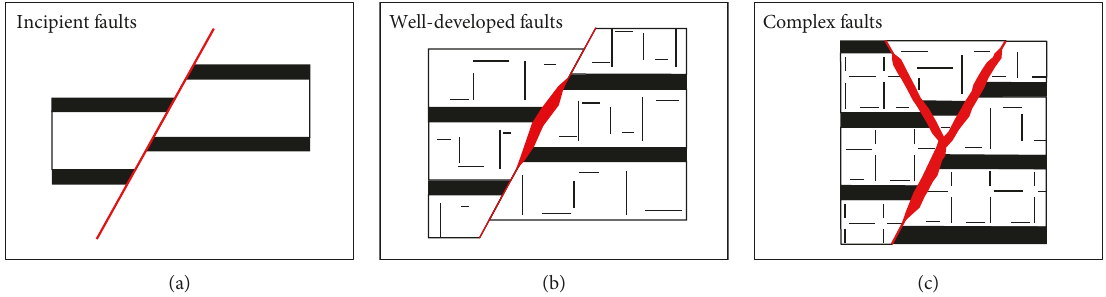
Figure 3: Faults were divided into groups based on the overall architecture. Black layers are representative of claystone, whereas the white beds represent a more competent layer, such as sandstone, limestone, and conglomerates. (a) Incipient faults are usually small in o ff set ( < 0.50m) and are characterized by their lack of fault core; (b) well-developed faults are characterized by the presence of a fault core (in red); (c) complex faults contain two or more fault planes that contribute to an overall more mature fault